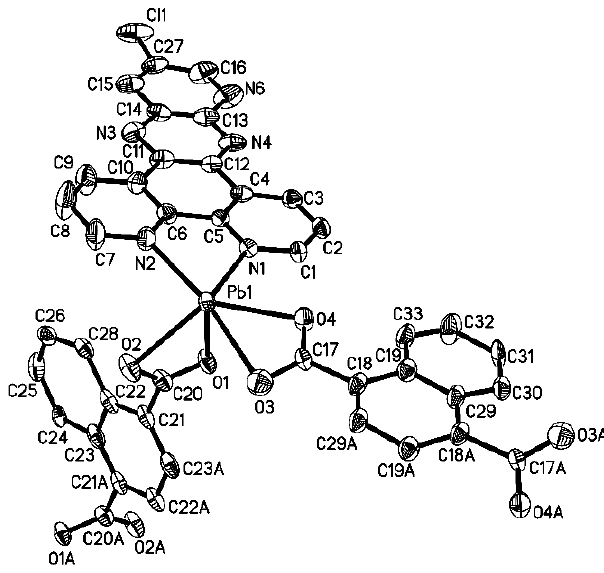
Table 1. Data collection and handling.